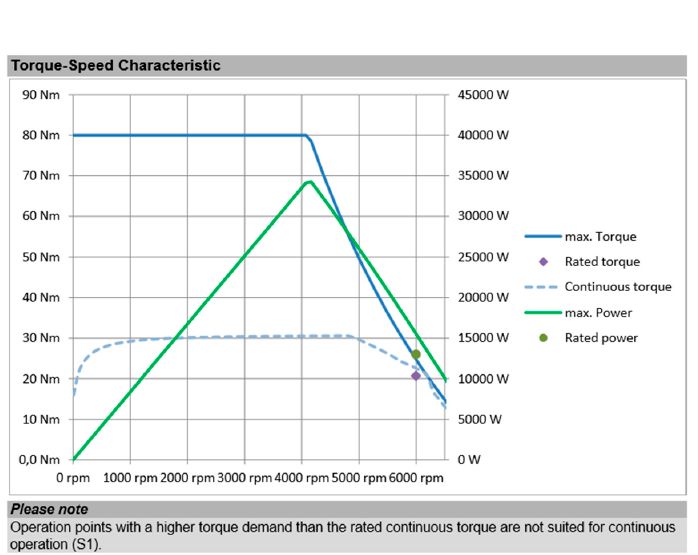
Figure 4. Power curve of the Heinzmann PMS150 motor [22].